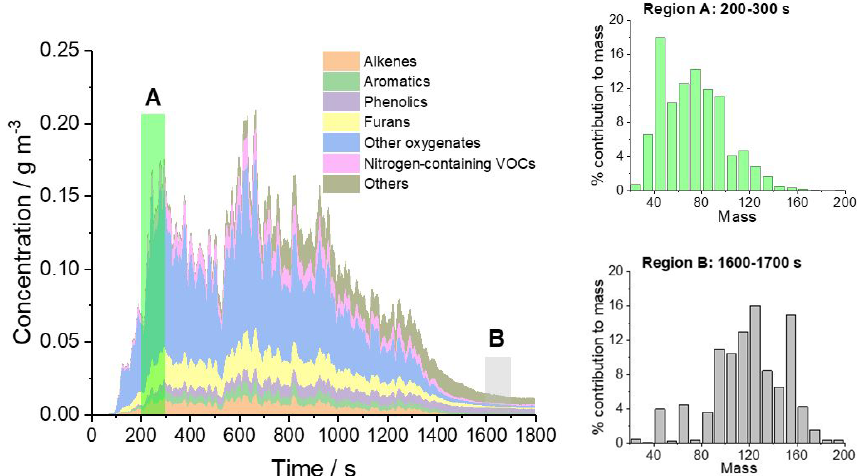
Figure 3. PTR-ToF-MS concentration–time-series plot during the first 30min of a cow dung cake burn coloured by functionality with regions A and B displaying mass spectra placed into m/z bins of 10Th. Fuel was collected from Pitam Pura, Delhi.